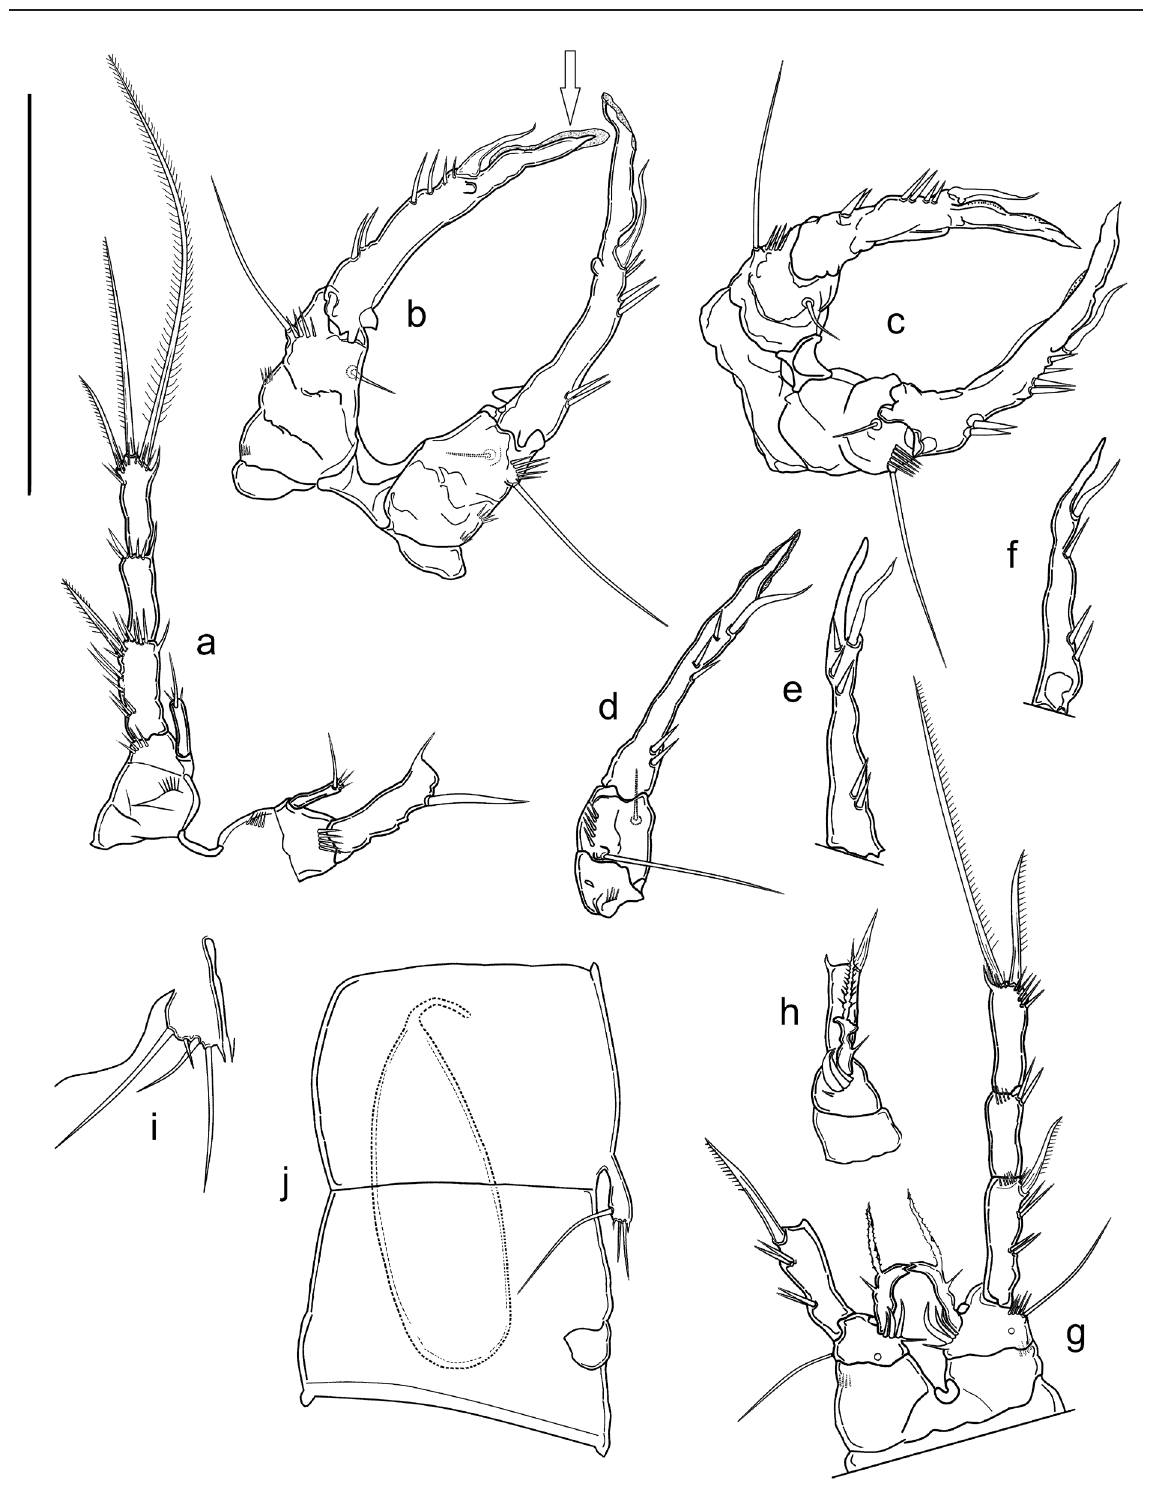
Fig. 10. Stammericaris vincentimariae Bruno & Cottarelli sp. nov., ♂ (NHMUK). a . P2, anterior view. b . P3, posterior view (hyaline membrane on tip of apophysis arowed). c . P3, anterior view. d . P3, outer view (variability). e . P3 exp, outer view (variability). f . P3 exp, outer view (variability). g . P4. h . P4 enp. i . P5. j . P5, P6, first and second urosomites, spermatophore, lateral view. Scale bar: 50